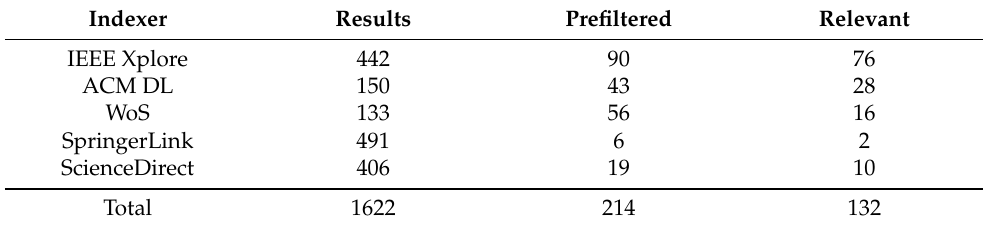
Table 3. Number of articles processed in the